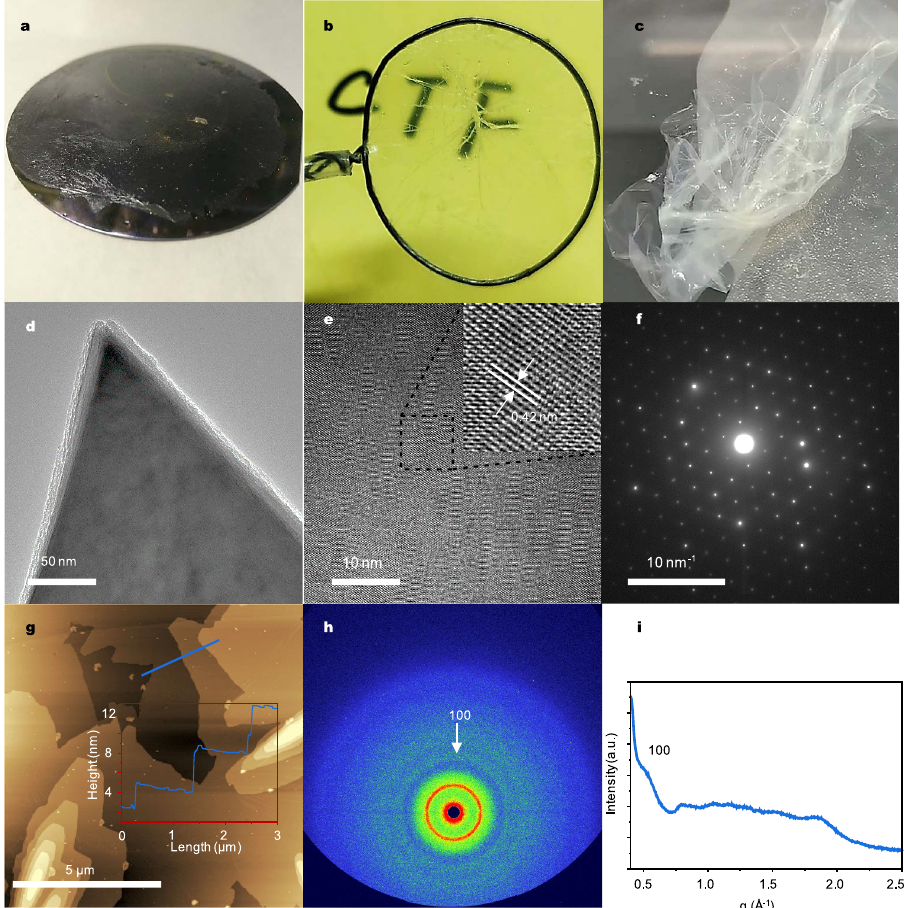
Fig. 2 Morphology characterization. a CTF fi lms on 4-inch 300 nm SiO 2 /Si wafer. b The free-standing and transparent CTF fi lm. c CTF fi lm immersed in the solvent. d , e HR-TEM images. f SAED image. g AFM image. h , i 2D SAXS image and their corresponding 1D SAXS pro fi les of the CTF fi lm. b